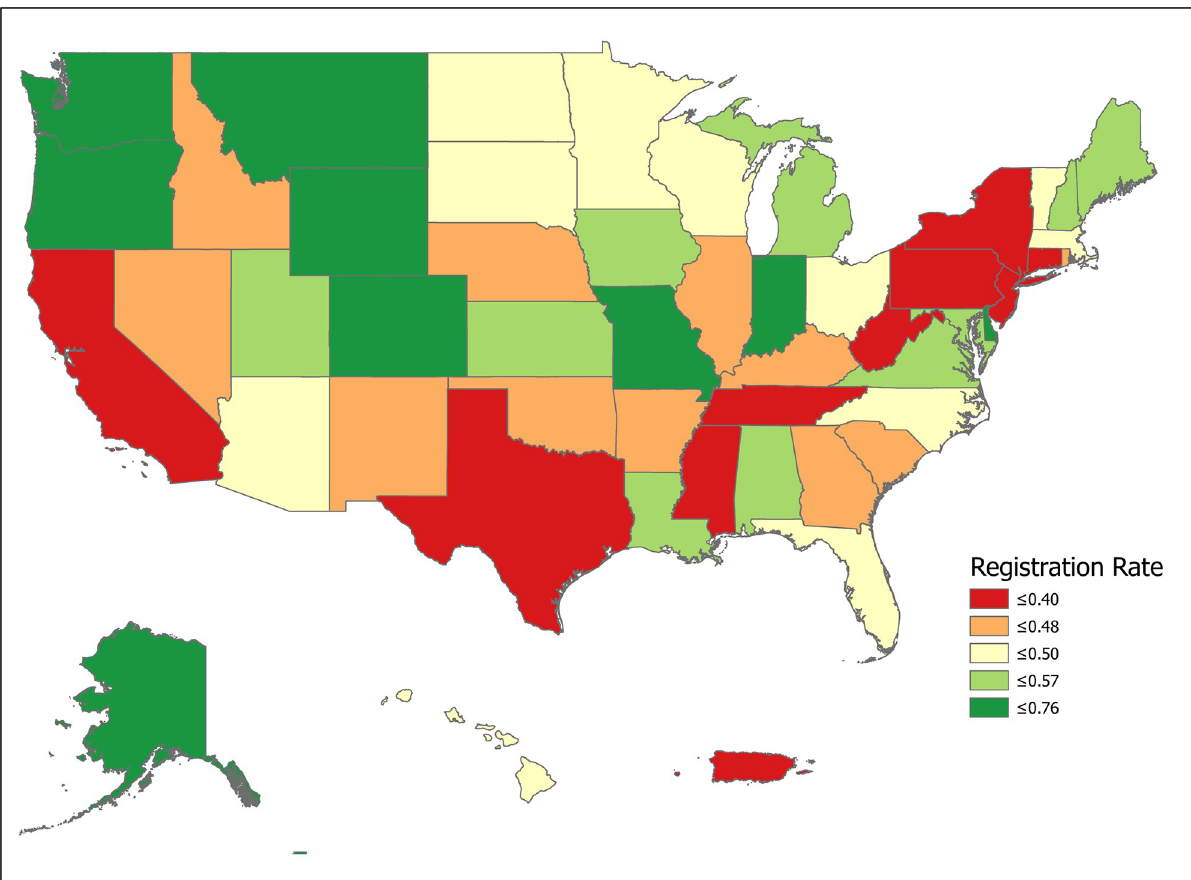
Fig 2. 2018 state donor registration rates. Data come from Tables 1 and 2. Maps created by ArcGIS Pro, URL: https://www.esri.com/en-us/arcgis/ products/arcgis-pro/overview. Base Map: World Light Gray Base, URL: https://services.arcgisonline.com/arcgis/rest/services/Canvas.